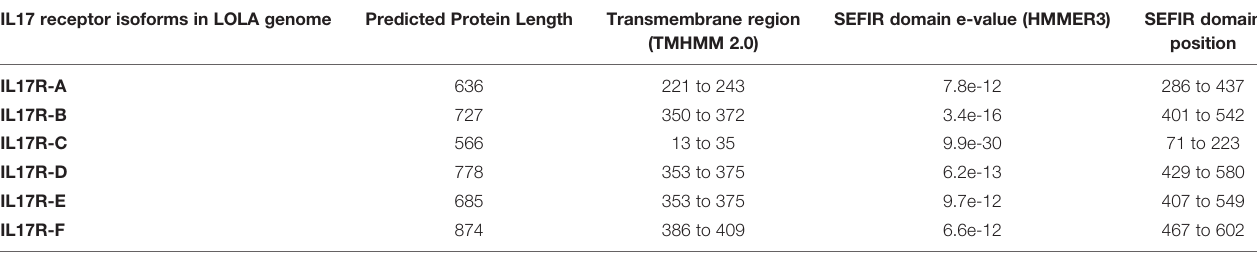
TABLE 3 | Sequence and domain information of the 6 isoforms of mussel IL-17R.